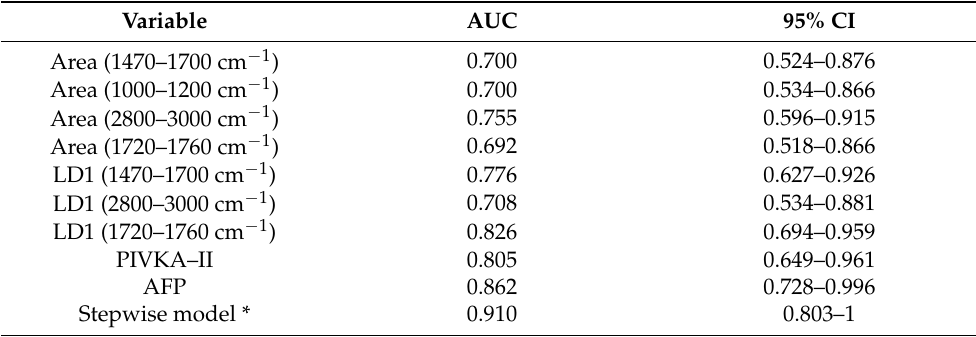
Table 2. ROC-AUC Table analysis of the significant spectral biomarkers highlighted in Figures 4 and 5. Conventional HCC circulating biomarkers—namely AFP and PIVKA-II—are also included in the analysis together with the results of a stepwise combined model selecting the most informative biomarkers for the classification of the two